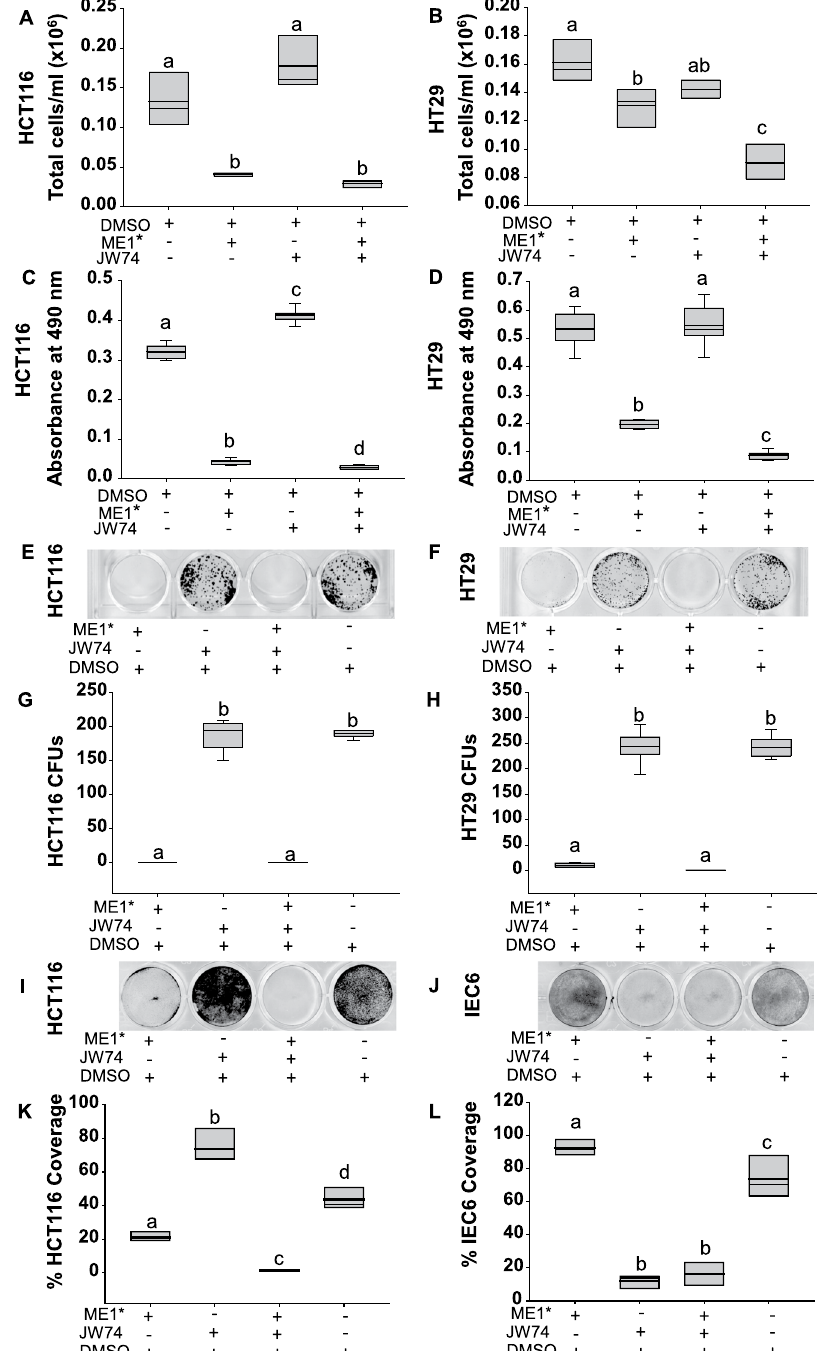
Figure 6. A small molecule inhibitor of ME1 26 suppressed colon cancer cell numbers in vitro . ( A,B ) Number of viable HCT116 and HT29 cells after treatment with 50 uM of ME1 inhibitor (ME1 * ), 15 uM of Wnt pathway inhibitor (JW74), 50 uM ME1 * plus 15 uM JW74, or vehicle (DMSO). Twenty thousand cells/well were plated and 24 h later received inhibitor(s). Cells were evaluated after 72 h of treatment (n = 3 wells/treatment group, data are representative of 2 independent experiments). ( C,D ) Results of MTS cell proliferation/cytotoxicity assay. Cells were plated at a density of 1000 cells per/well and 24 h later received treatments (50 uM ME1 * , 15 uM JW74, 50 uM ME1 * plus 15 uM JW74, or vehicle (DMSO)). Absorbance (490 nm) was measured at 48 h after treatment addition; n = 8 wells/treatment group, data are representative of 2 independent experiments. ( E,F ) Results of clonogenic assay. HCT116 or HT29 cells were plated at a density of 1000 cells/well and after 24 h were treated with 50 uM ME1 * , 15 uM JW74, 50 uM ME1 * plus 15 uM JW74, or vehicle (DMSO). After incubation for six days, cells were stained with crystal violet. ( G,H ) Quantification of colony forming units (CFU) from ( E , F) after treatment of cells (n = 6 wells/treatment group). ( I,J ) Results of modified clonogenic assay. HCT116 and IEC6 cells were plated at very high density (100,000 cells/well) and after 24 h were